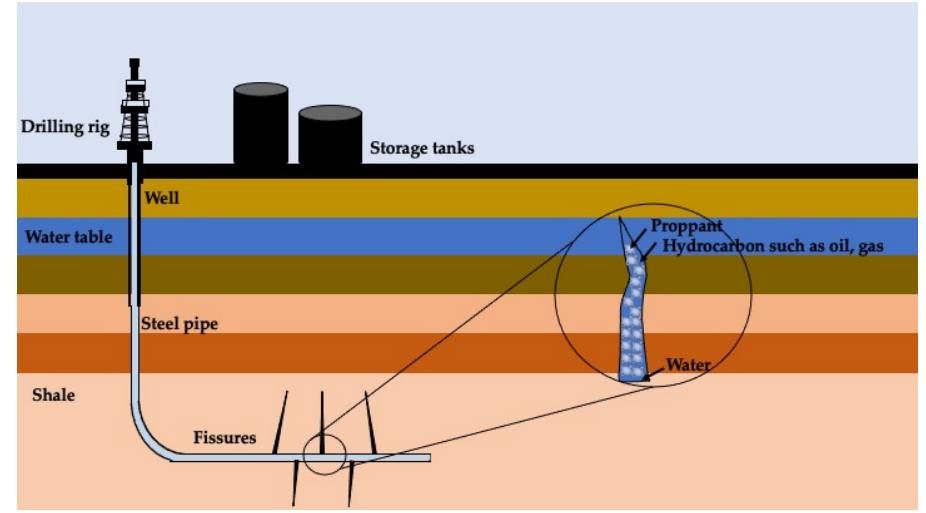
Figure 19. Hydraulic fracturing, modified from [209,211].